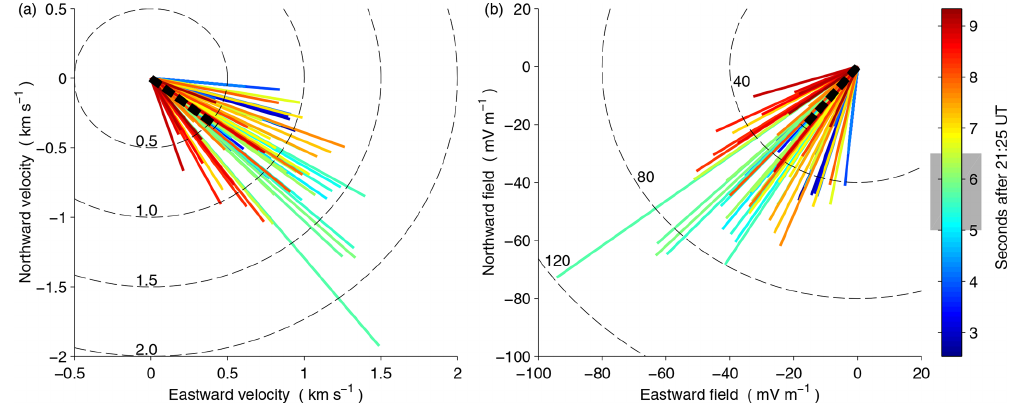
Figure 8. Magnitudes and directions of (a) the best-fit plasma velocities and (b) the inferred electric fields. The dashed circles are magnitude contours. The colour of each line indicates the time of the velocity or field, and the shaded region of the colour bar indicates when the arc brightened. The thick dot-dashed lines indicate the SuperDARN estimate of the average plasma velocity and electric field.